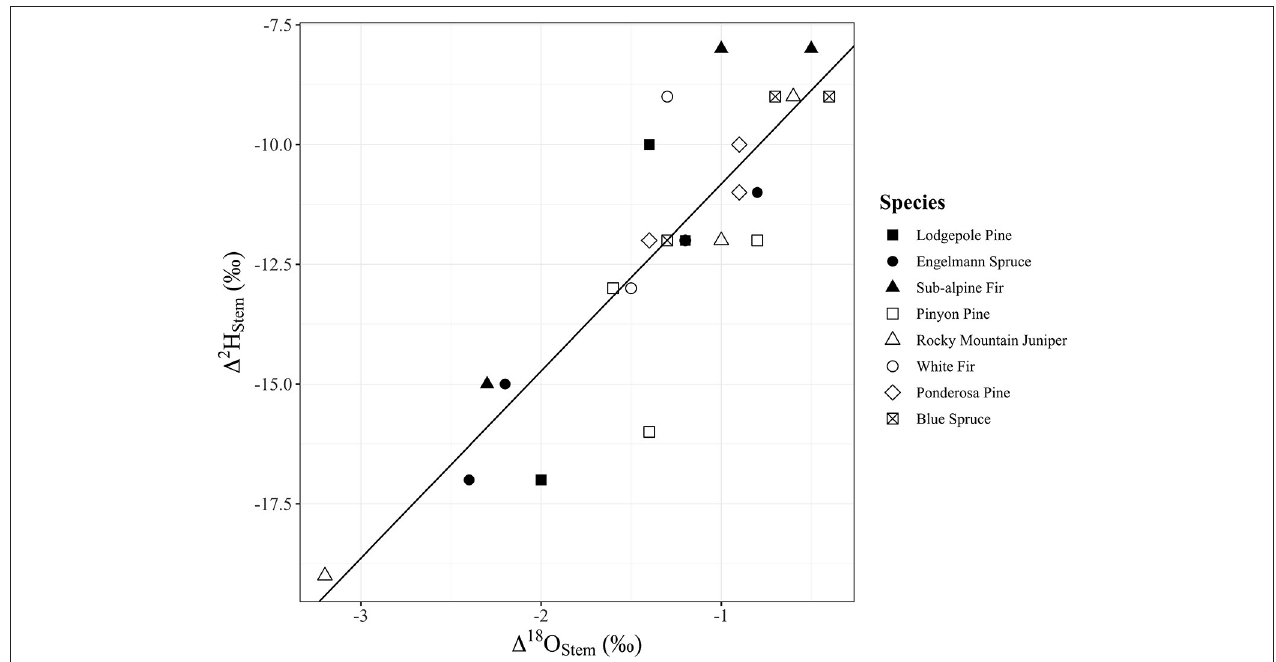
FIGURE 8 | Significant positive relationship between 1 2 H stem and 1 18 O stem for each individual tree ( y = 3.91 x – 6.92, p = < 0.001, R 2 = 0.76). Points shapes are different for each species with filled in point shapes from the Med Bow location and remaining point shapes from the Campus